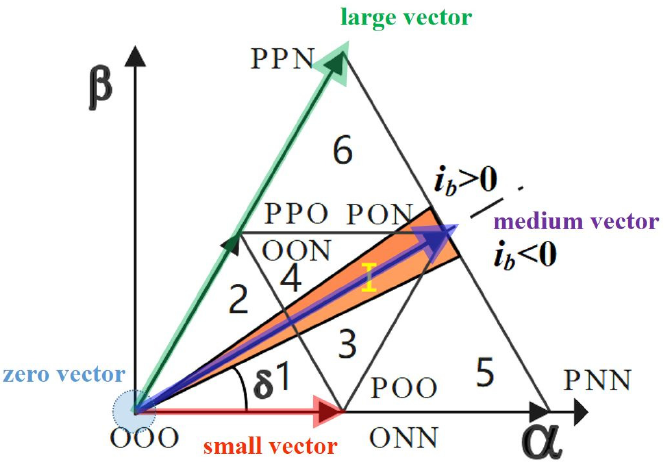
Figure 7. Zero-crossing distortion region in large sector I.